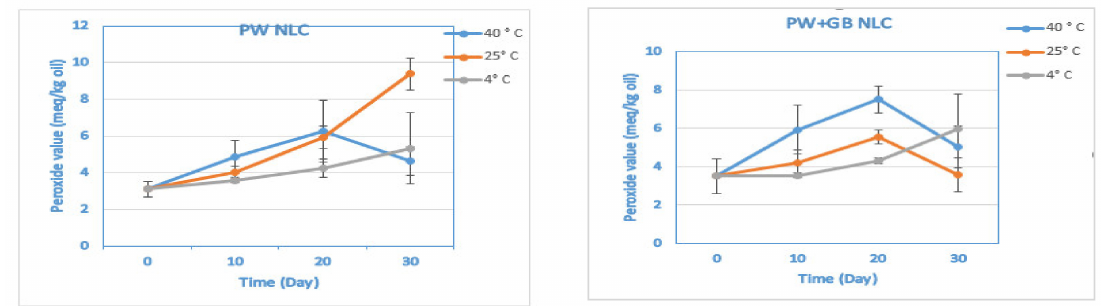
Figure 3. Oxidative stability of β -sitosterol NLC dispersions by peroxide value (PV) (meq / kg oil) during storage at di ff erent temperatures (4, 25 and 40 ◦ C). PW and PW + GB represent the NLCs formulated with propolis wax alone or its binary mixture with glyceryl behenate (1:1), respectively.